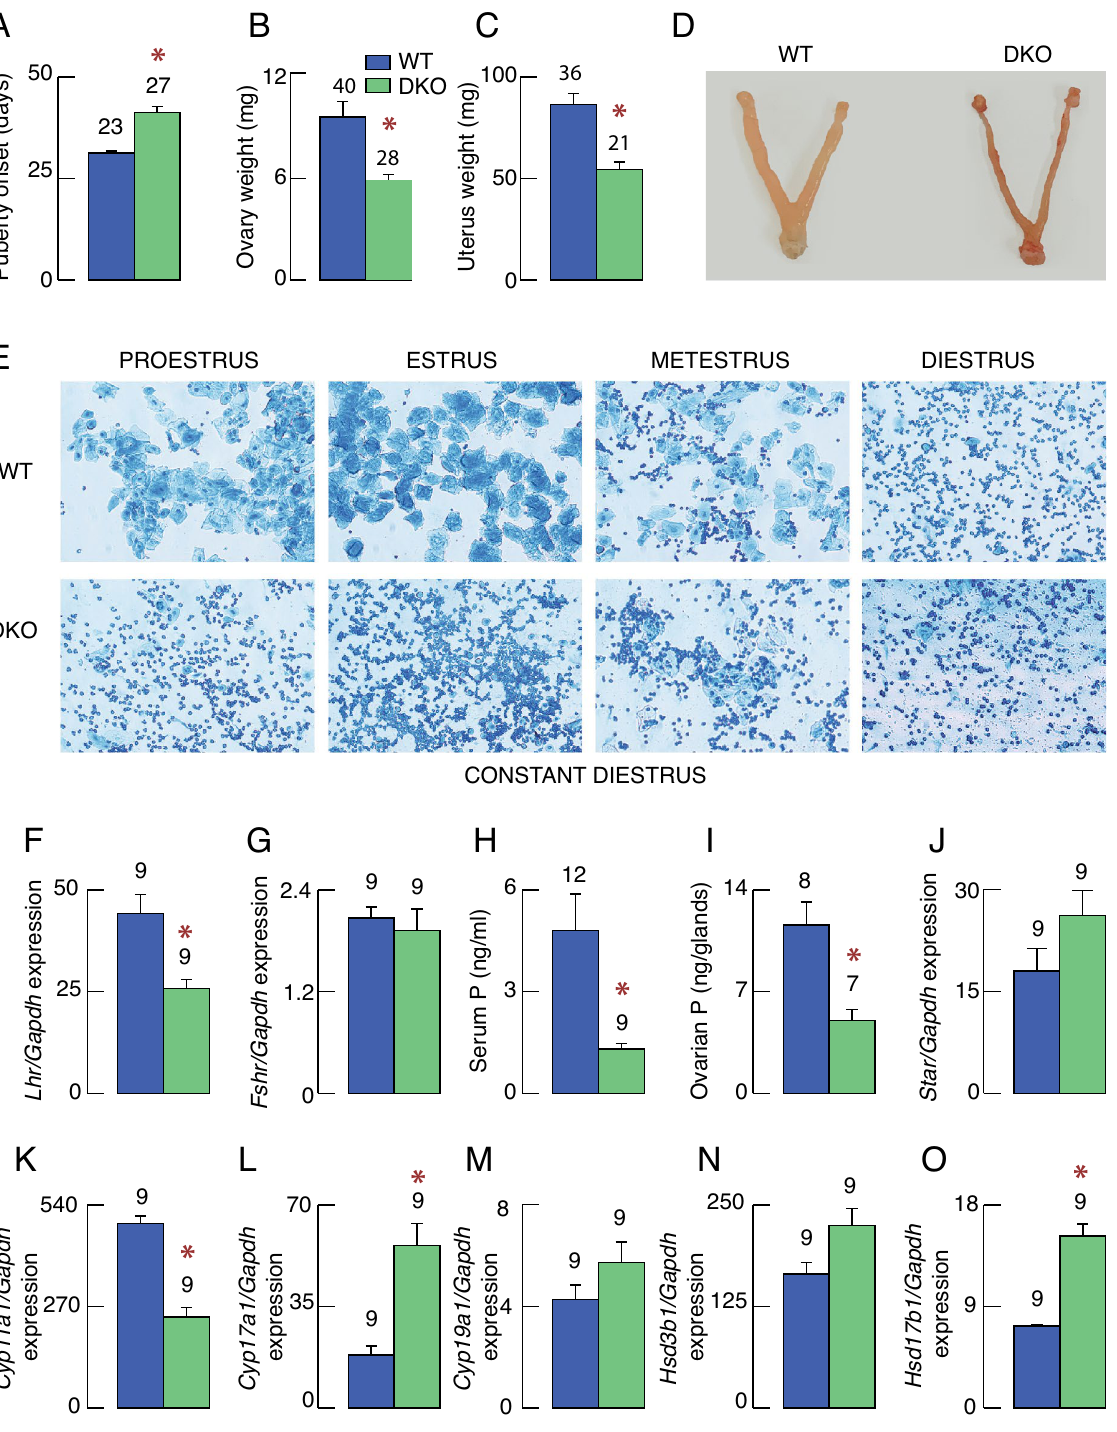
Figure 1. Effects of Ptprn and Ptprn2 double knockout (DKO) on the female reproductive system. ( A ) Difference in onset of puberty in wild type (WT) and DKO females. ( B – D ) Reproductive organs in WT females in the diestrus stage of the estrous cycle and DKO females: the averaged weight of ovaries (B) and uterus (C) and representative examples of these organs (D). ( E ) Representative vaginal smears in WT and DKO females. Smears were taken daily for two weeks. ( F , G ) Expression of gonadotropin hormone receptor genes Lhr (F) and Fshr (G) in ovaries. ( H,I ) Gonadal steroid hormones in WT females in the diestrus stage of the estrous cycle and DKO females: serum (H) and ovarian (I) progesterone. ( J – O ) Ovarian steroidogenic gene expression in WT and DKO animals: Star (J), Cyp11a (K), Cyp17a1 (L), Cyp19a1 (M), Hsd3b1 (N) and Hsd17b1 (O). In this and following figures, bars shown are mean ± SEM values; dark blue bars denote WT and green bars DKO animals; numbers above bars indicate number of replicates per group; asterisks, P < 0.01 between pairs. The age of animals (days) was WT = 110 ± 3.6 (N = 40); DKO = 115 ± 3.8 (N = 28); animal body weight (g) was WT = 20.65 ± 0.28; DKO 21.32 ±